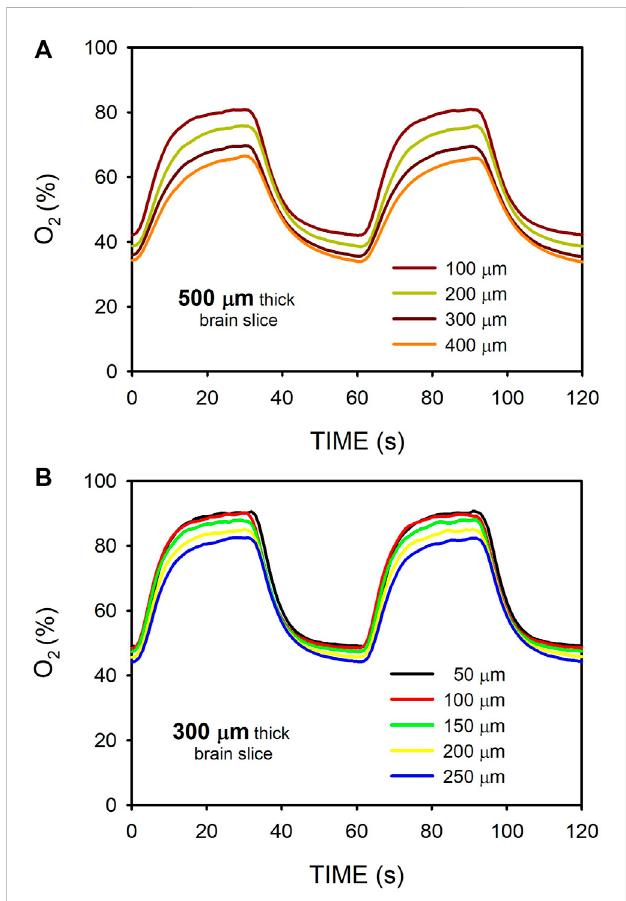
FIGURE 7 Oxygen concentration measured at different positions (Figure 2A) within mouse brain slices when the intermittent air circulating beneath the membrane was 95% O 2 for 30 s and 50% O 2 for 30 s. (A) O 2 measured at the hippocampus of a 500- μ m thick slice. (B) Same as in (A) for a slice thickness of 300- μ